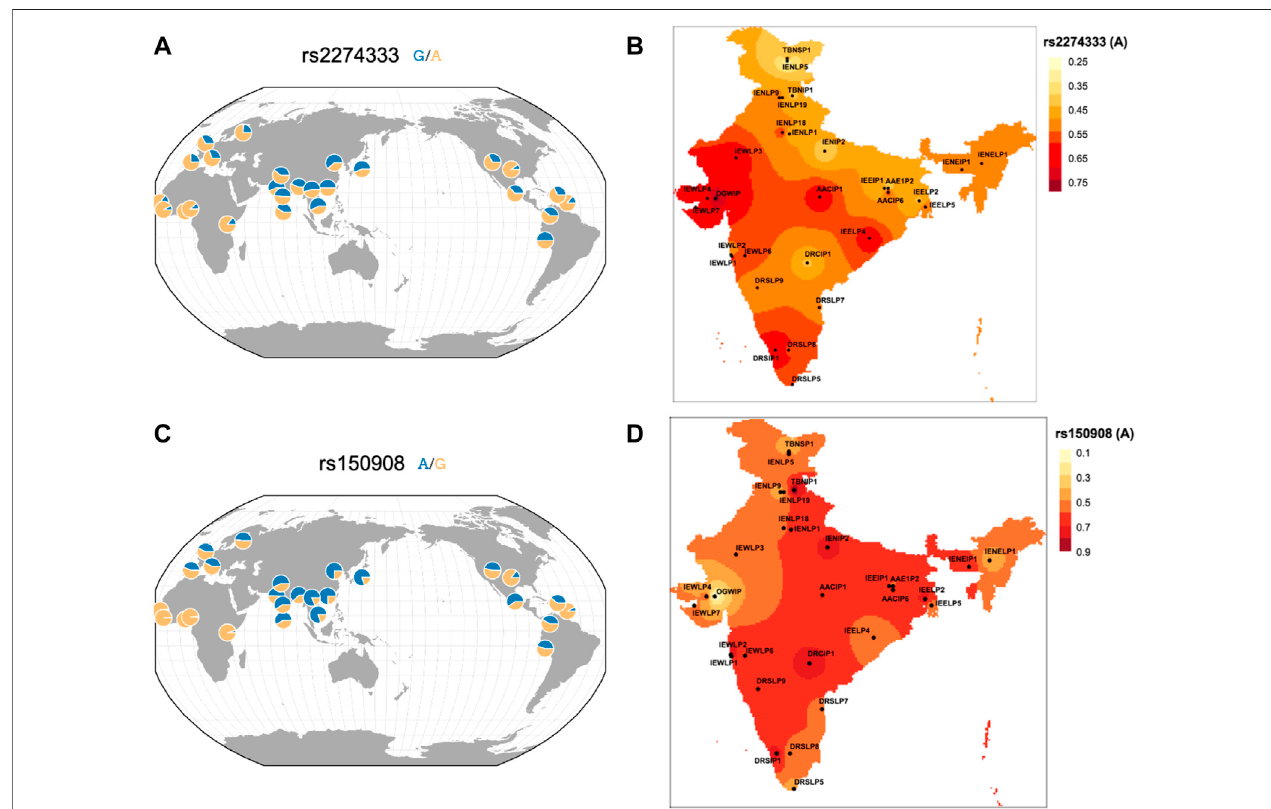
FIGURE 3 | Spatial plot of frequency distribution of high differentiating variants (A) rs2274333 of CA6 gene in worldwide geographical population and (B) in IGVC populations of India and (C) rs150908 of TRPV1 gene in worldwide geographical population and (D) in IGVC populations.